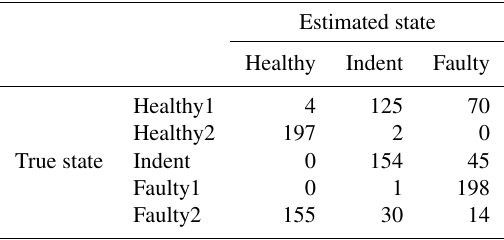
Table 9. Confusion matrix for 1500rpm MEMS data and the top four features, classifier trained with ramp-up data.